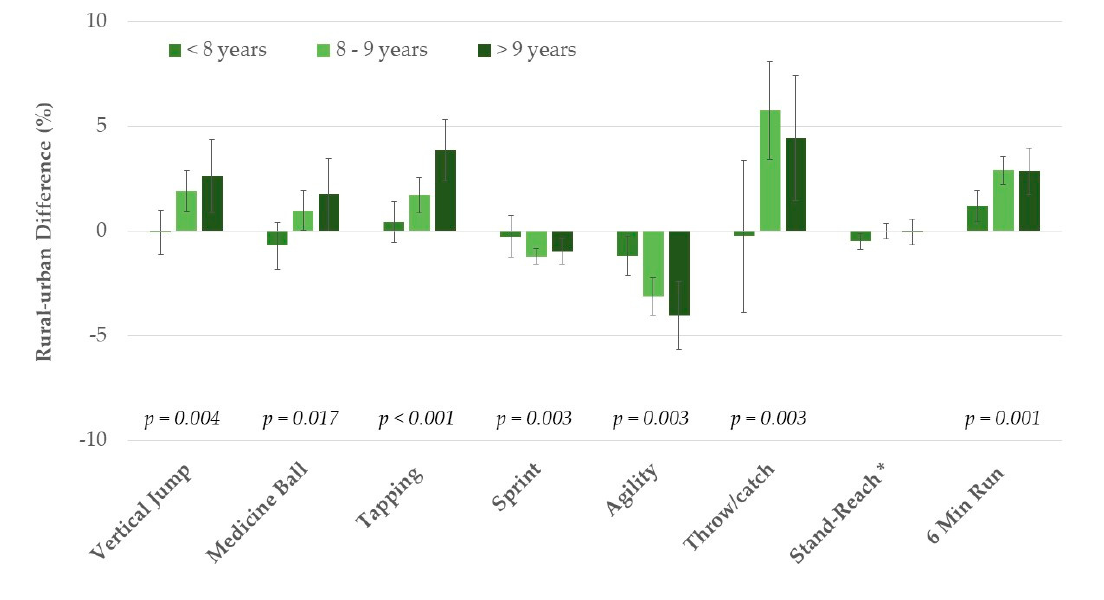
Figure 2. Rural–urban differences by age group in non-overweight children. Values are mean differences, adjusted for sex with 95% CI, and p -values reflect significance for age-by-living area interaction.